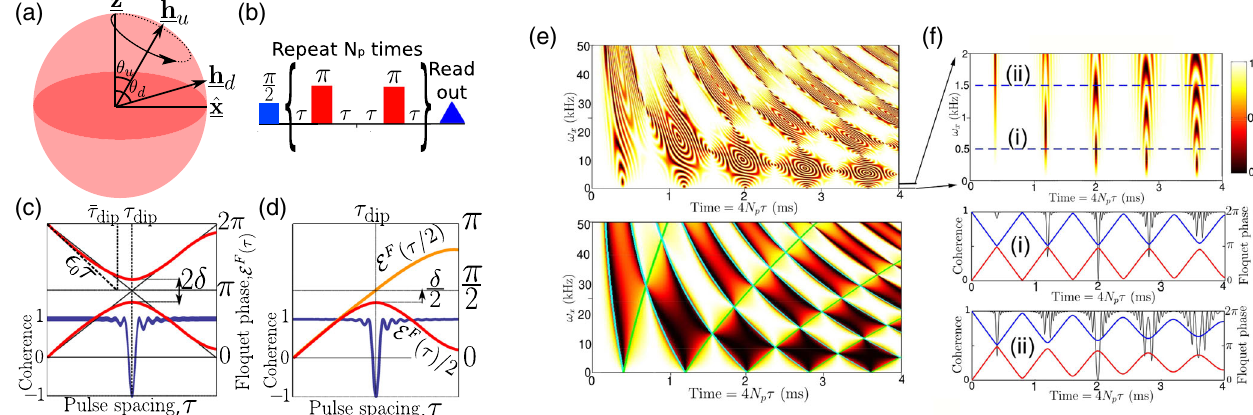
FIG. 2. (a) Usual geometric approach. Under CPMG-N control (b) the detected spins represent two-state systems that precess about effective magnetic field, dependingon the “ up ” j u i and “ down ” j d i statesof theprobe spin. Thecoherence dipsare understoodby following theprecessions andrelative anglesbetweenthesespins,withincreasing N .(c)Spectroscopicpicture.Thedipsincoherence occuratavoided crossings of the Floquet eigenstates. Boththe position and contrast of the decoherence dip are related to the curvature of the crossing. This is characterized by the splitting between the states 2 δ and the deviation from the early τ → 0 linear evolution. The early time evolution (the ϵ 0 = 2 Þ ¼ π = 2 . (d) The dip quasienergy) gives the dip position ¯ τ for average Hamiltonian theory; the coherence minimum is given by E ð τ dip dip Þ = 2 − E ð τ = 2 Þ(cid:2) . contrast depends on the degree of curvature of the crossing, characterized by the level-repulsion strength, δ ¼ 2 ½ E ð τ dip dip (e) NV-center decoherence “ diamonds. ” While typical experimental studies scan along parallel field ( ω z ) component (thus remaining in weak-coupling, single-dip regime), scanning the transverse magnetic field ( ω x ) would produce diamond pattern of high-decoherence regions, as avoided crossings widen (and even overlap) then narrow (here, ω z ¼ 0 and A ∥ ¼ 50 kHz). The upper panel shows full oscillating coherence function, for N p ¼ 10 pulse pairs; the lower panel shows coherence envelopes, filled as N p → ∞ . Here, ω ¼ 0 . Boundaries of the diamonds trace out (green) τ ¼ π = 2 ð ω þ ω Þ and (cyan) τ ¼ π = 2 ð ω − ω Þ (see text). (f) Expanded version z d u d u of low-field region showing shape of avoided crossings versus coherence traces corresponding to two cuts (i),(ii), indicated in the upper